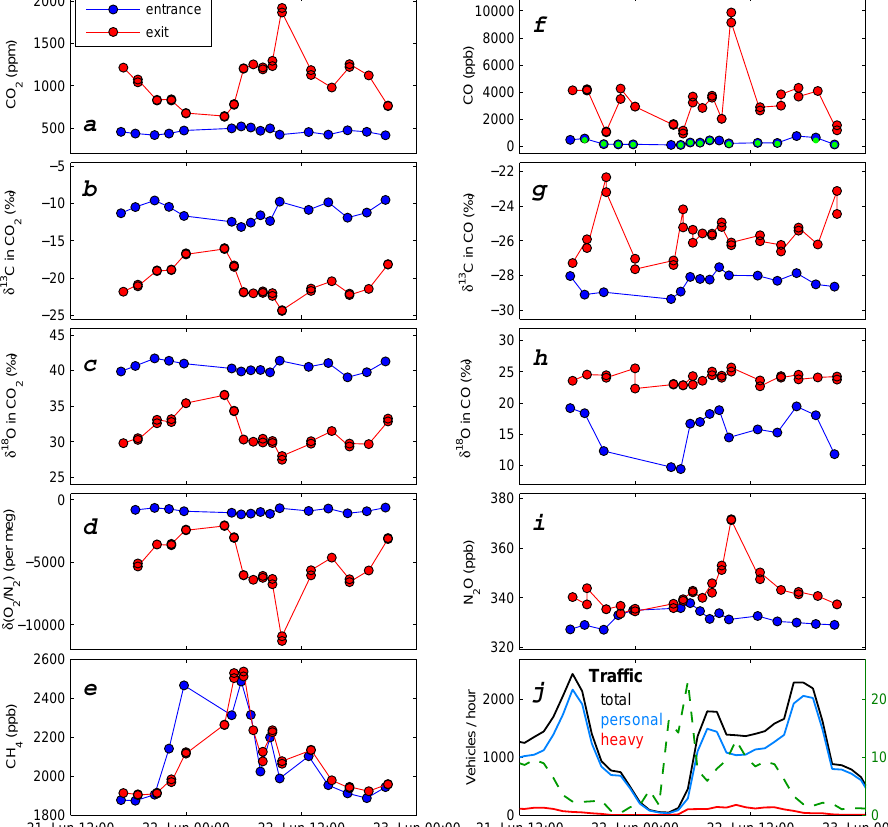
Fig. 1. (a–i) Results of the flasks sampled during 21–22 June 2011 (the intensive flask sampling campaign). O 2 /N 2 , CO 2 , 13 C and 18 O in CO 2 , N 2 O and CH 4 were measured by MPI-BGC. 13 C and 18 O in CO were measured at IMAU. CO mole fractions were measured both at MPI-BGC and IMAU; the green dots show the results from MPI. (j) Traffic count hourly data during the same time interval, showing separately the personal vehicle category and the “heavy traffic” category (which includes all large vehicles: trailers, trucks and busses). The dotted green line shows the proportion of heavy traffic (right-hand